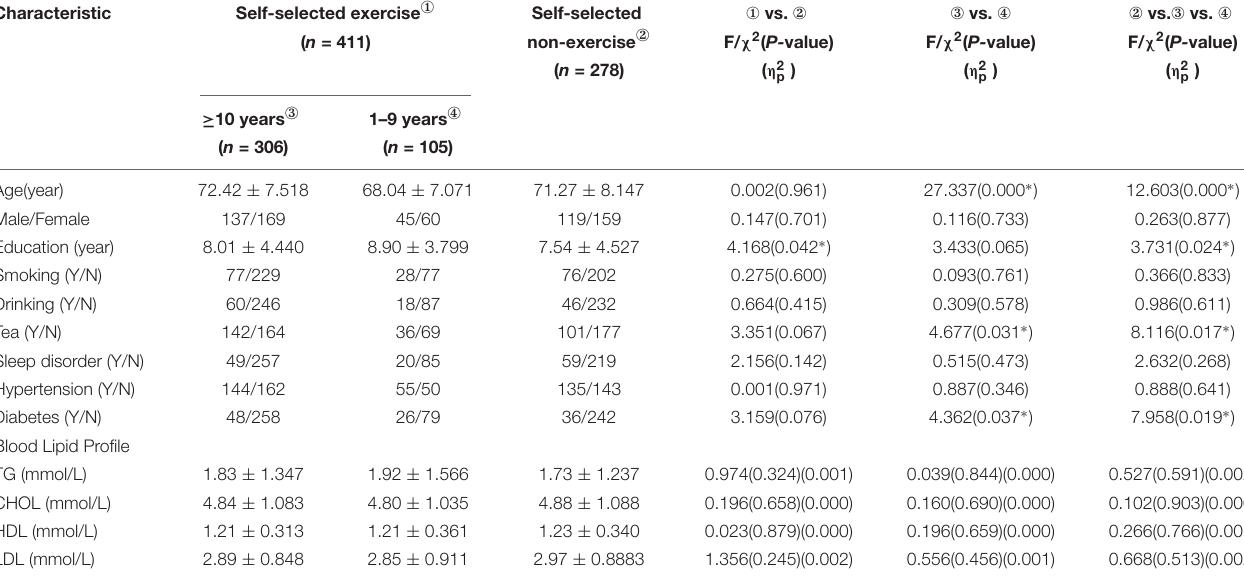
FIGURE 1 | Cognitive functions in self-selected exercise and self-selected non-exercise groups. (A) Significant differences were apparent of baseline and 1 year follow-up MMSE scores between self-selected exercise and self-selected non-exercise groups. (B) Significant differences of baseline and 1 year follow-up MoCA scores were apparent between self-selected exercise and self-selected non-exercise groups. TABLE 2 | Demography, life style, physical diseases, and lipid profile of study participants in the database subgroup on a non-dementia elderly Chinese population.